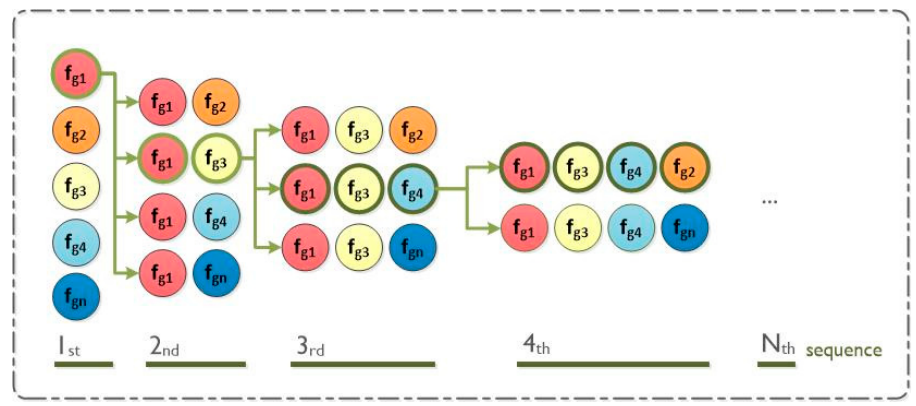
Figure 6. Group-wise forward feature selection scheme, where f gi is a group of features, e.g., f g1 = all features on date 1, f g2 = all features on date 2, etc. In the first sequence, f g1 is selected as the best (highest accuracy) of all feature groups. In the second sequence, each of the remaining feature groups is evaluated pair-wise together with already selected ones. The sequences are continued until the final set of features is evaluated.